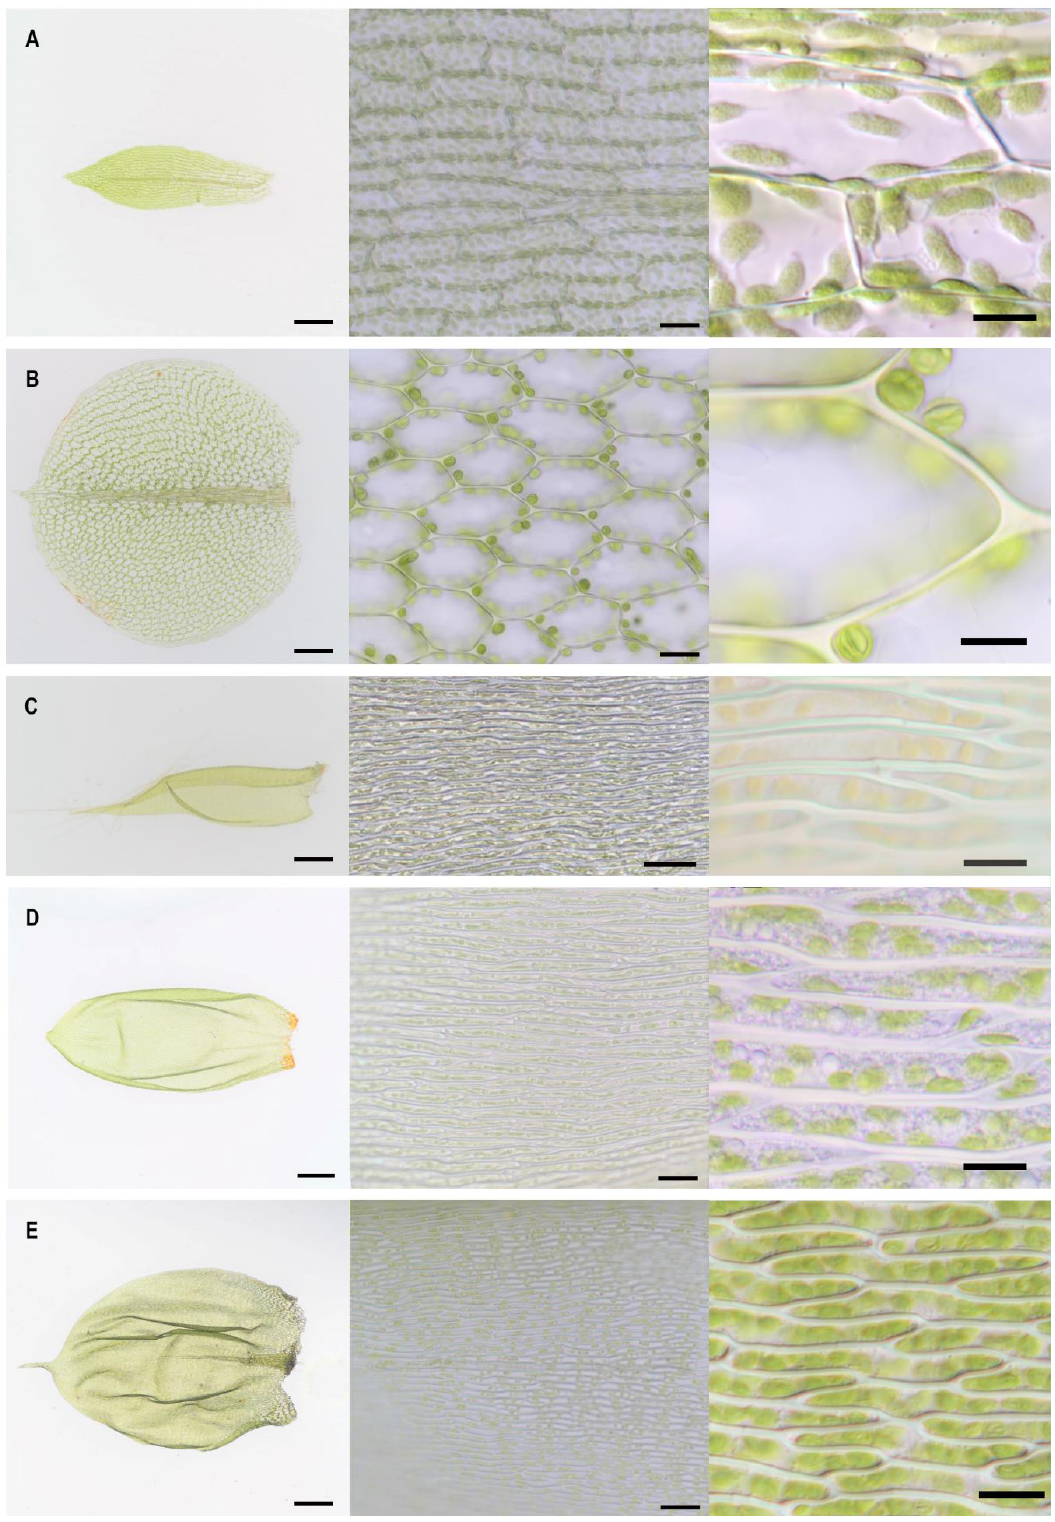
Figure 1. Lamina and cell shapes of five selected bryophyte species ( A ) Physcomitrium patens , ( B ) Plagiomnium affine , ( C ) Hypnum cupressiforme , ( D ) Pleurozium schreberi , and ( E ) Pseudoscleropodium purum. Bar: 250 μM for leaflet (overview); 25 μM for the respective cell shape (middle panel); 10 µM for close up (right panel).